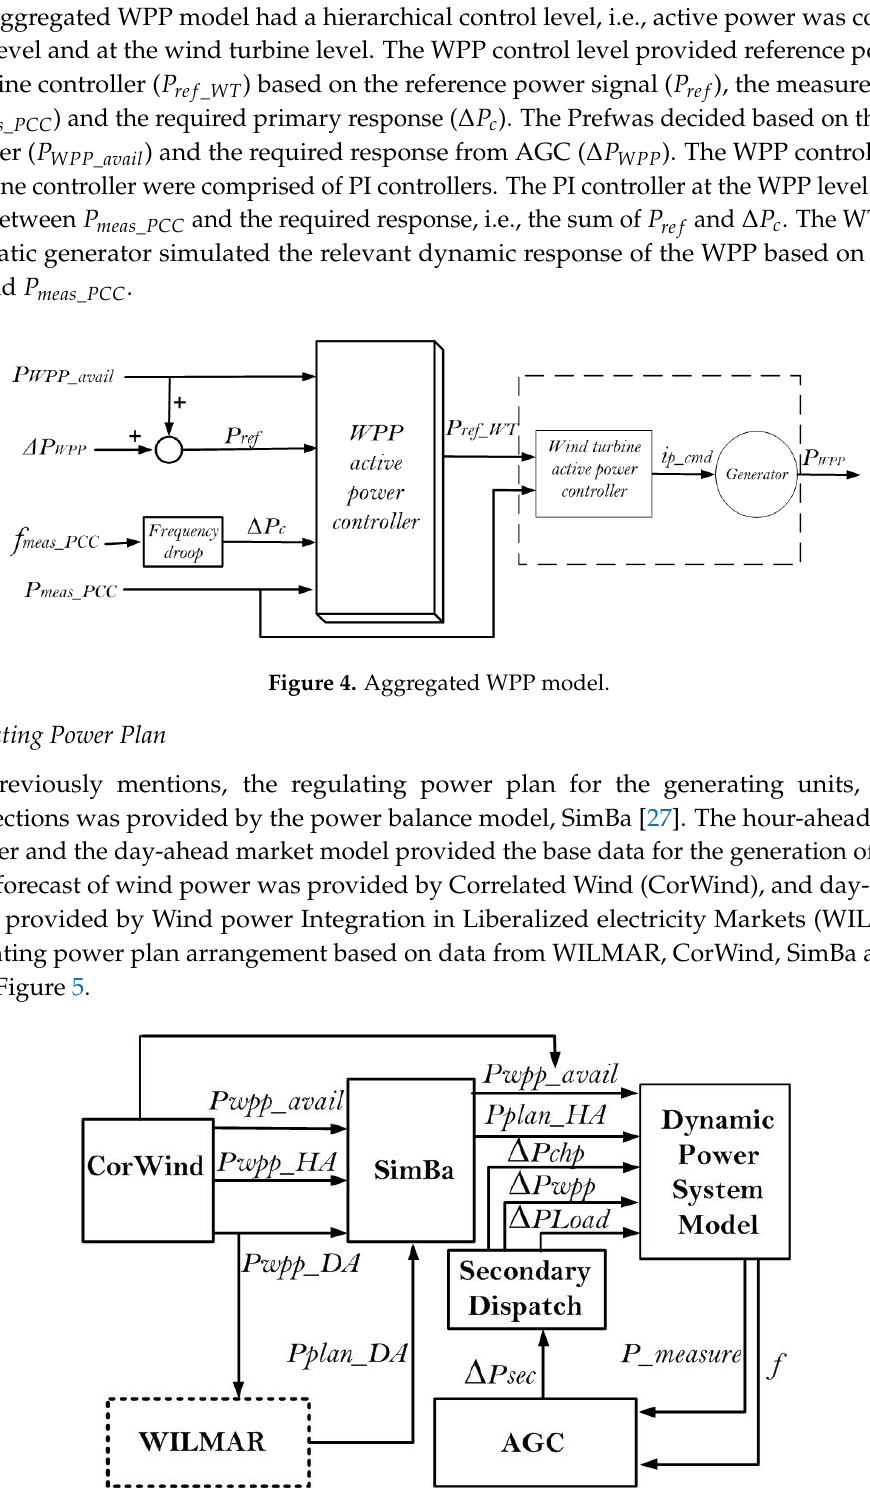
Figure 5. Regulating power plan arrangement based on data from Wind power Integration in Liberalized electricity Markets (WILMAR), Correlated Wind (CorWind), SimBa and